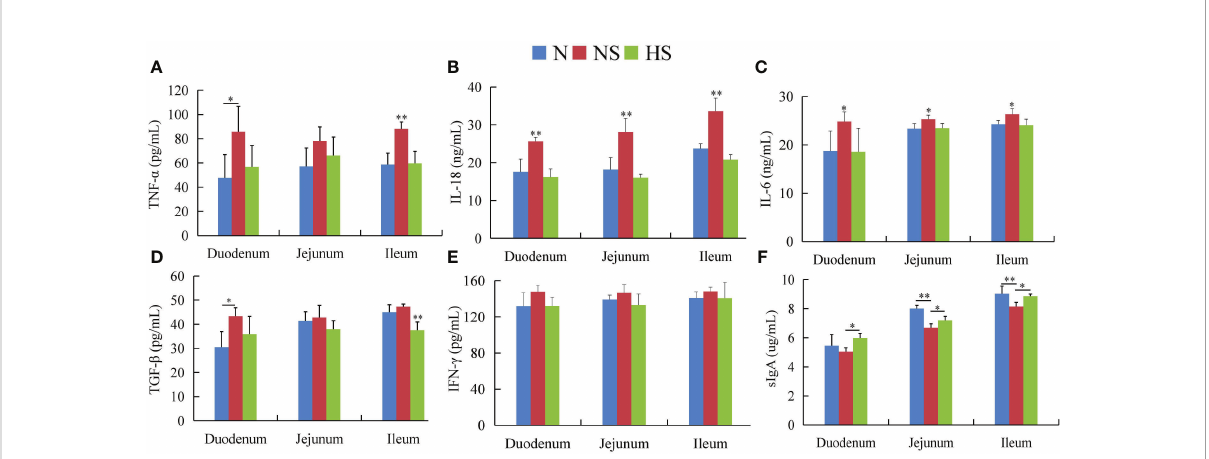
FIGURE 3 Effect of Terminalia bellirica (Gaertn.) Roxb. on intestinal cytokine secretion and intestinal sIgA in Salmonella Typhimurium -infected mice.